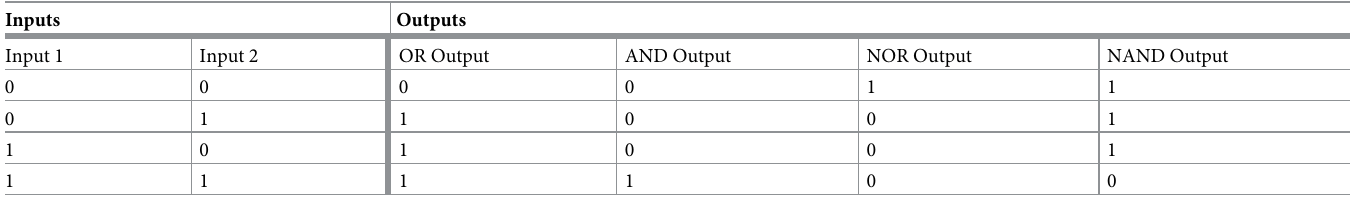
Table 1. Truth table of logic gates (OR, AND, NOR, NAND). Inputs Outputs Input 1